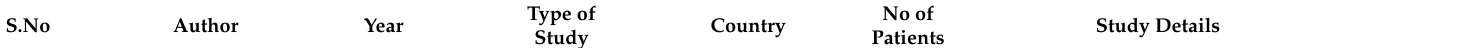
Group A: given 3 mL PRP intra-articularly. Group B: hydro-dissection (20 mL normal saline + 5 ml lignocaine) intra-articularly.